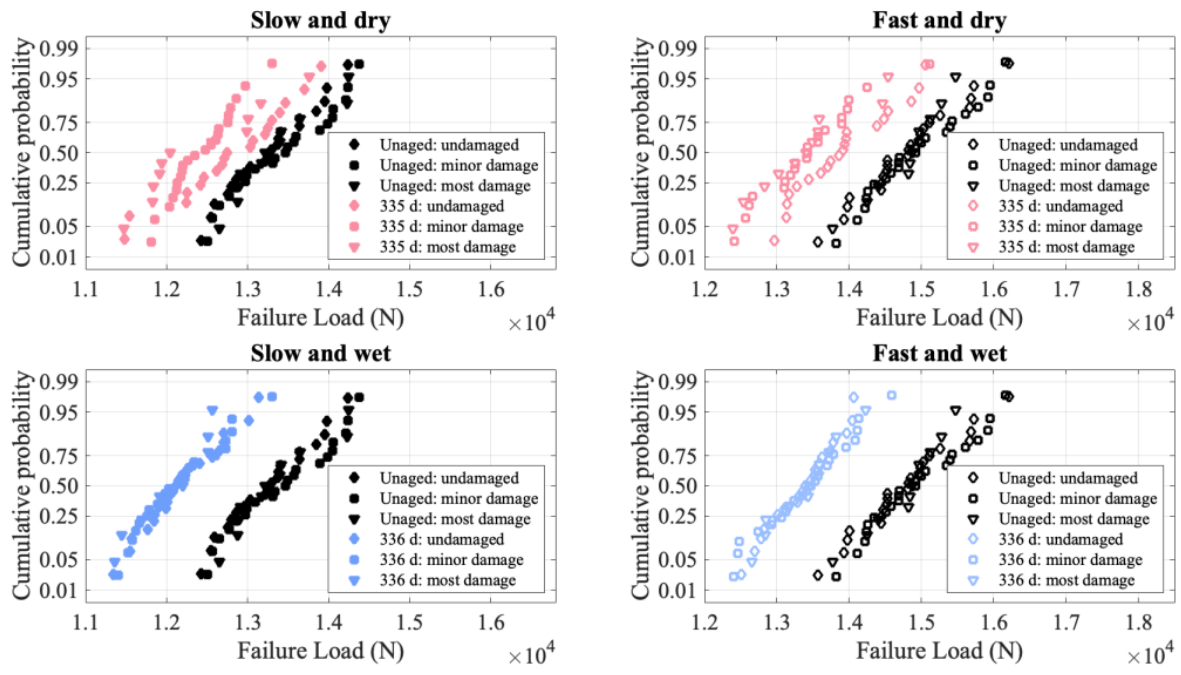
Figure 7. Normal probability plots of failure load (in Newtons) for unaged and most aged material, comparing three categories of damage as visually assessed before aging.